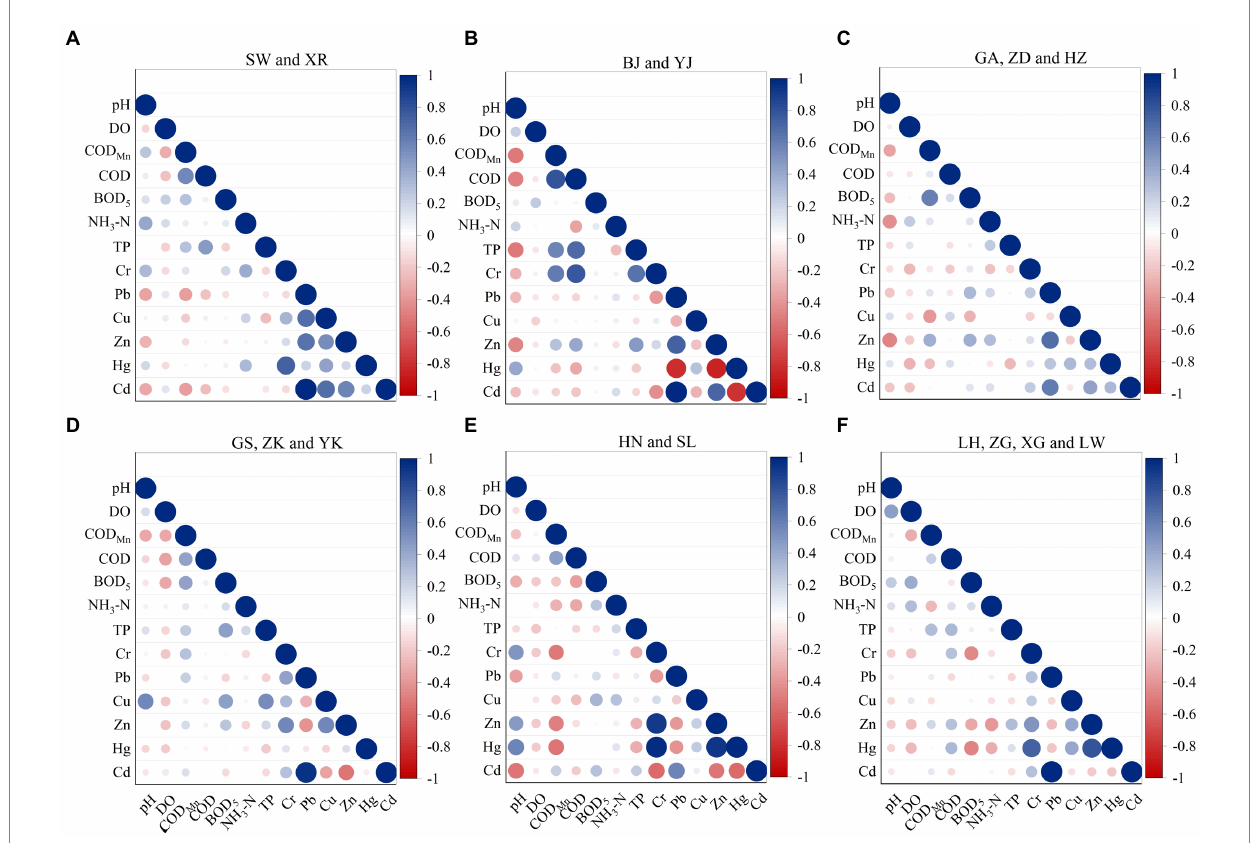
FIGURE 5 Pearson correlation analysis of water quality indicators based on different cluster groups: (A) SW and XR, (B) BJ and YJ, (C) GA, ZD and HZ, (D) GS, ZK and YK, (E) HN and SL, (F) LH, ZG, XG and